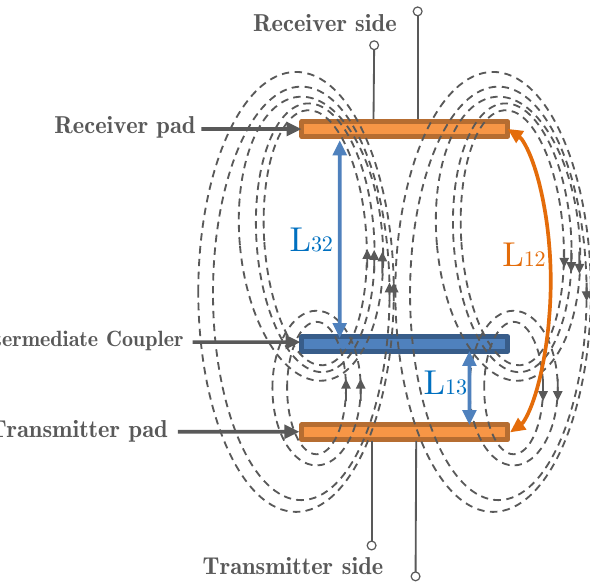
Figure 1. Magnetic coupler with the inclusion of an intermediate